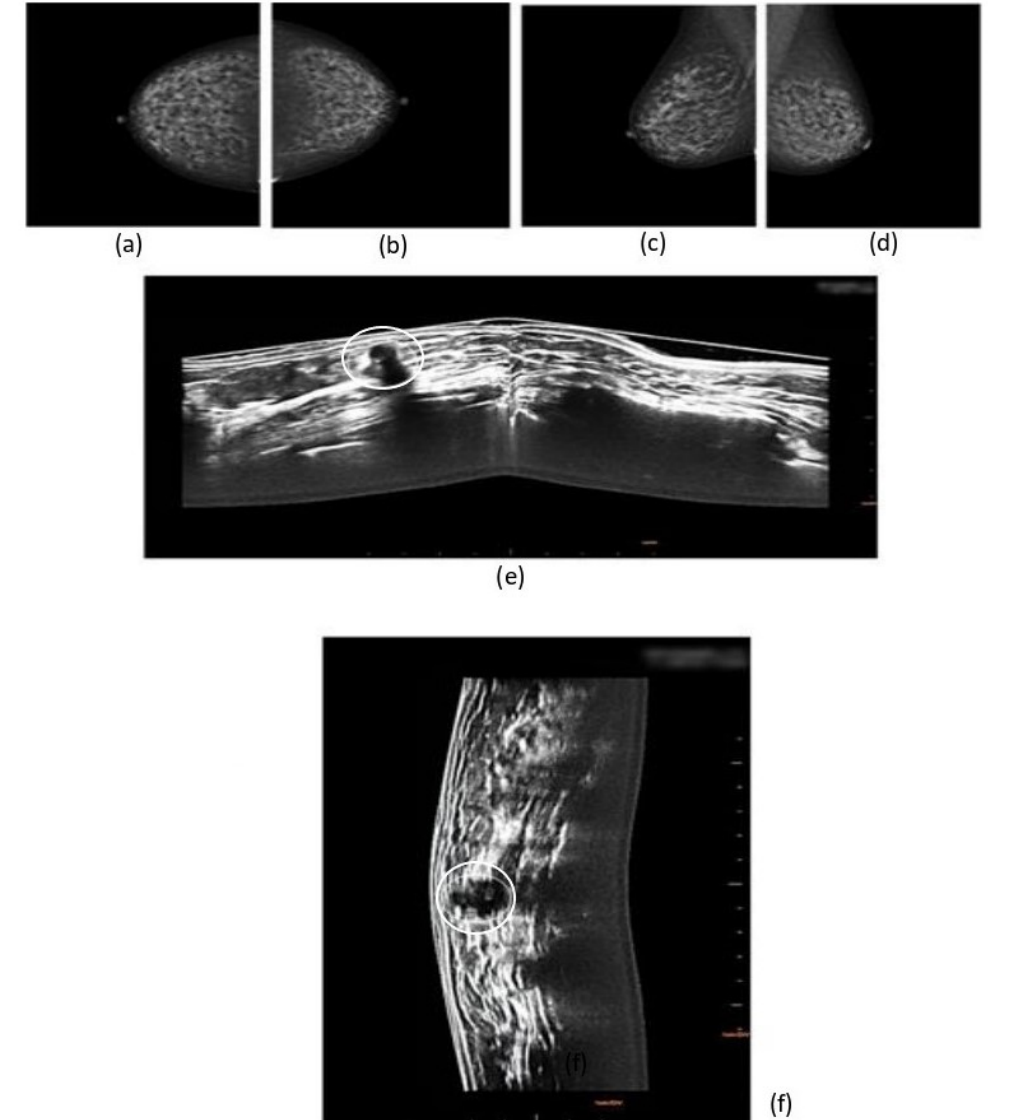
Figure 4. 3D Prone ABUS Images of ductal invasive cancer not detect with the mammography. ( a ) Full field digital right craniocaudal breast mammography. ( b ) Full field digital left craniocaudal breast mammography. ( c ) Full field digital right mediolateral-oblique breast mammography. ( d ) Full field digital left mediolateral-oblique breast mammography. ( e ) 3D Prone ABUS right breast transversal plane image showing node negative invasive ductal cancer (white circle). ( f ) 3D Prone ABUS left sagittal plane reconstruction (white